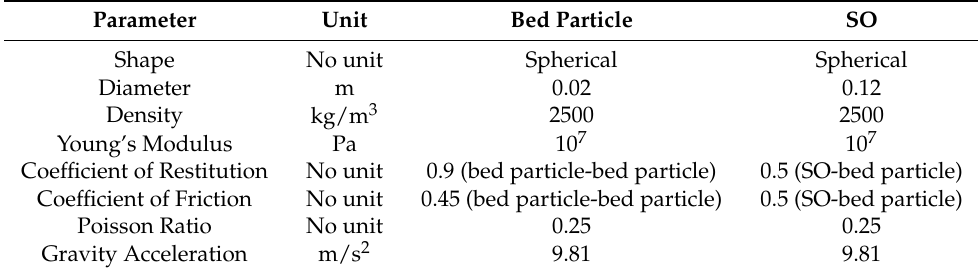
Table 1. The material properties used in the